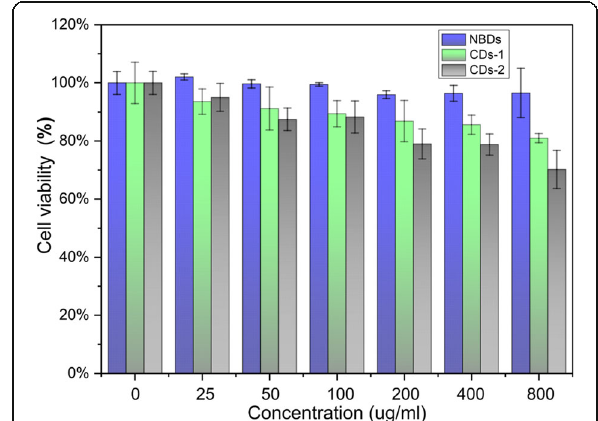
Fig. 4 Viability of HeLa cells after 72 h of incubation with different concentrations of NBDs and